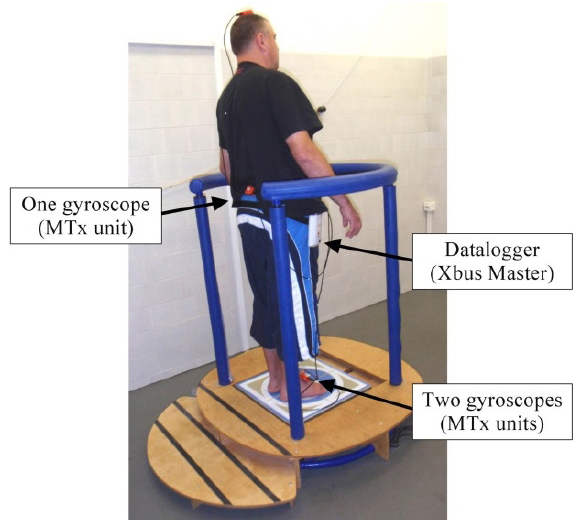
Figure 1. The gyroscope sensors (MTx units) used to measure the trunk and feet angular